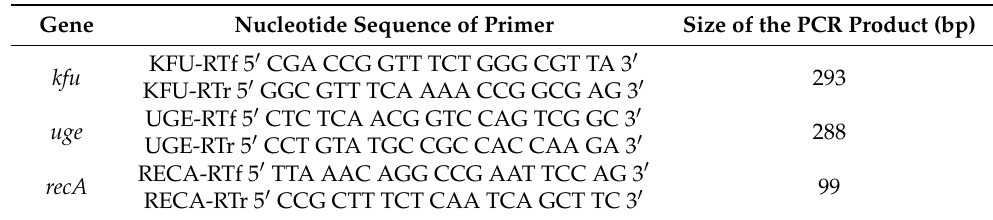
Table 2. Nucleotide sequences of primers for real-time PCR and sizes of the PCR products obtained from each pair of